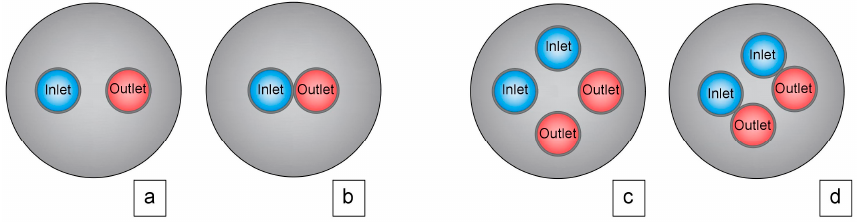
Figure 2. Position of single and double U-tube heat exchangers when using or not spacers. ( a ) Single U-tubes with spacers; ( b ) Single U-tubes without spacers; ( c ) Double U-tubes with spacers; ( d ) Double U-tubes without spacers.